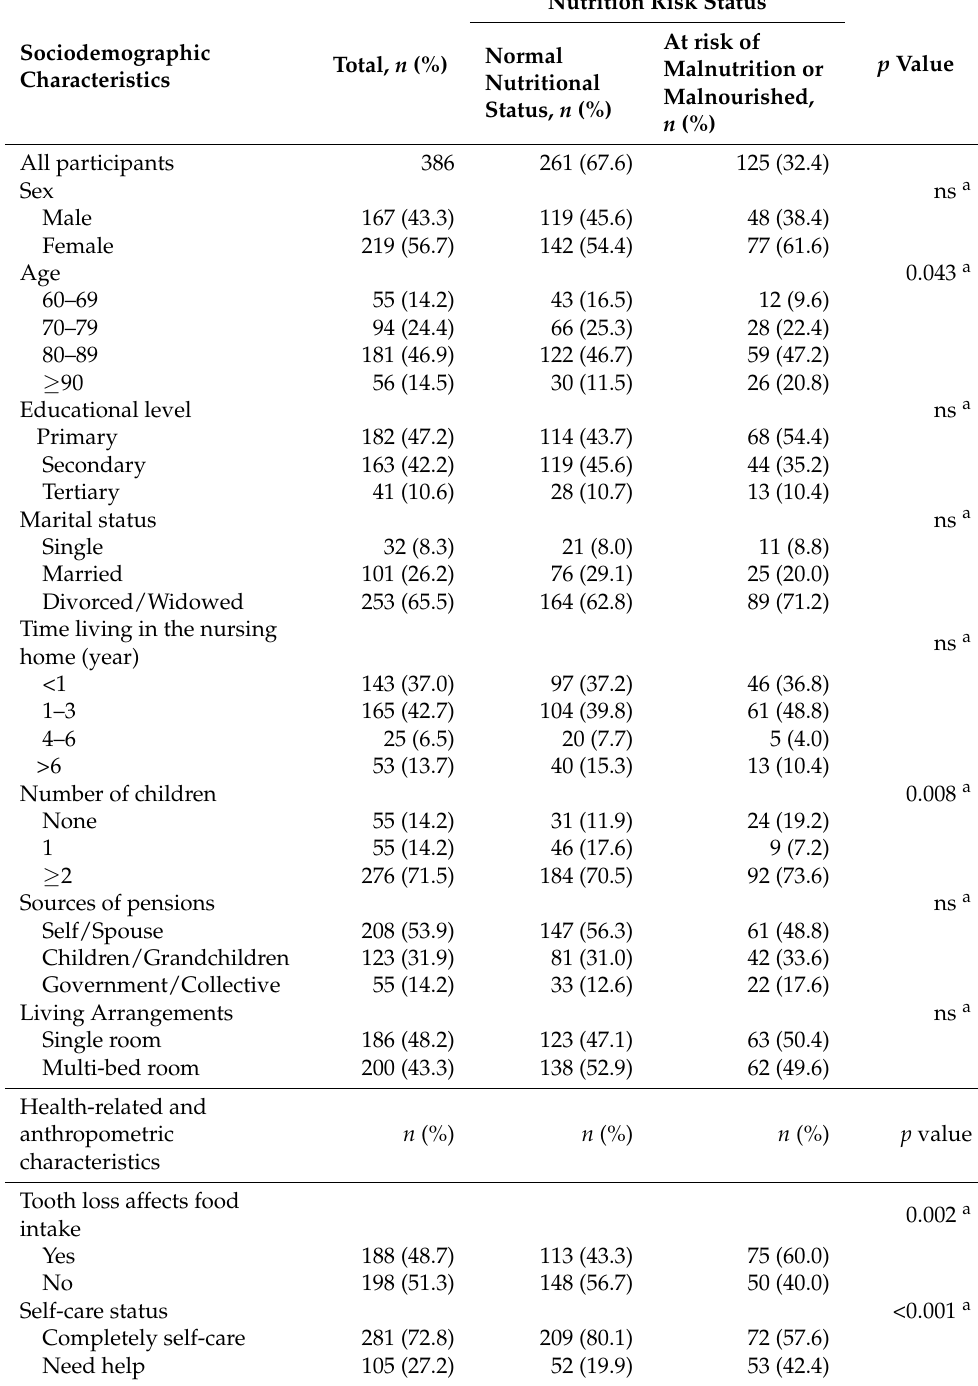
Table 1. Participants’ characteristics by nutritional